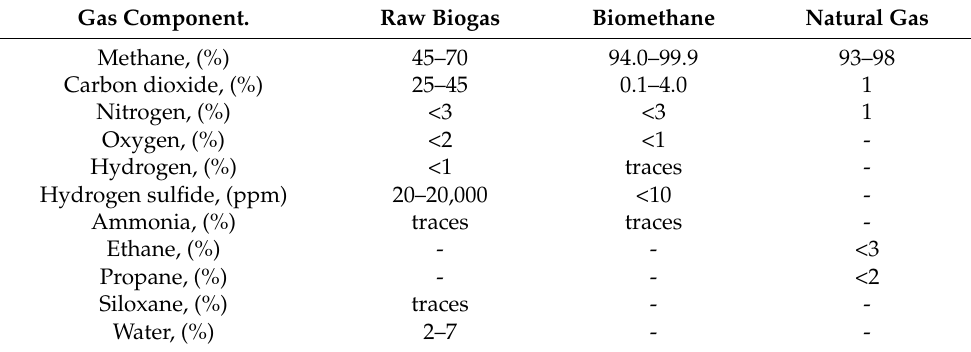
Table 1. Differences in the composition of raw biogas, biomethane and natural gas [60,61]. Gas